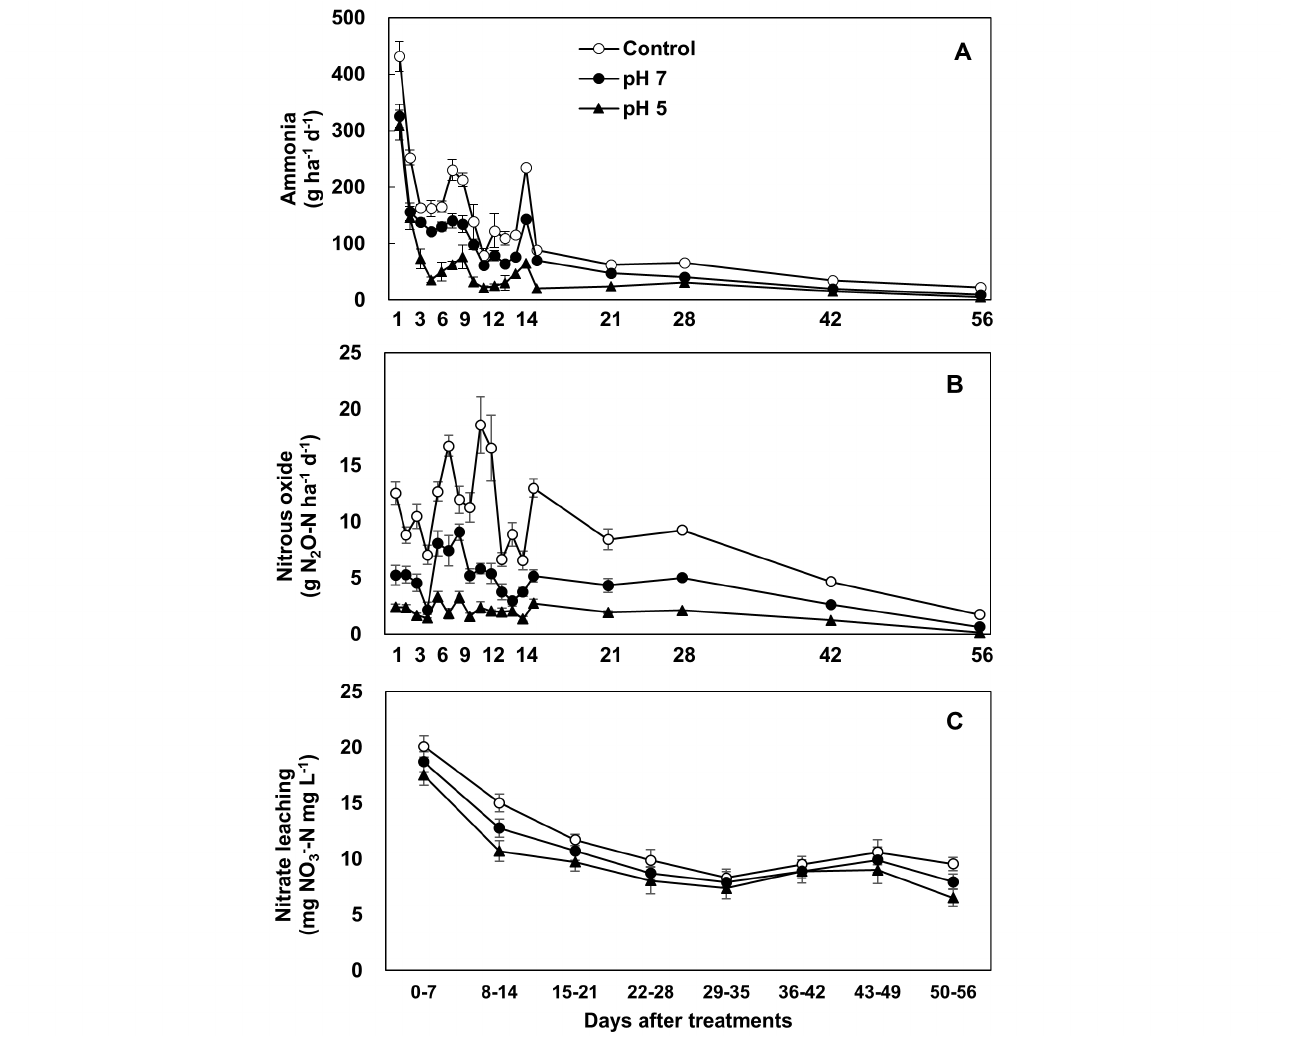
Figure 1. Daily emission of ammonia (A) and nitrous oxide (B), and weekly accumulative nitrate concentration in leachate (mg NO 3– -N/L, C) from the soil amended with untreated (control, ○ ), mutualized (pH 7, ● ) and acidified pig slurry (pH 5, ▲ ) during regrowth of perennial ryegrass sward. The values are mean±standard deviation of four